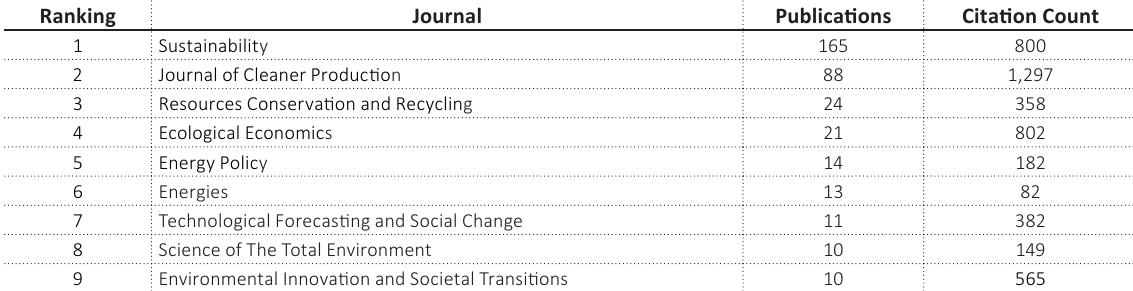
Table 3. Top 9 most constructive academic journals related to this study (2010–2020)